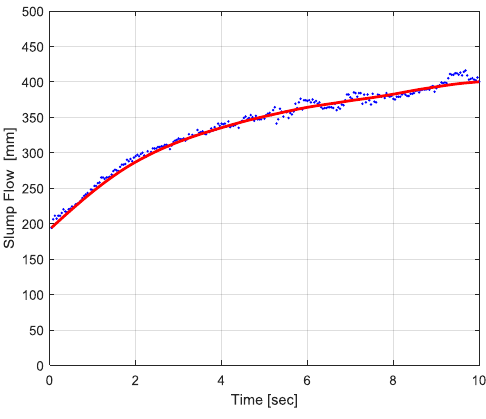
Figure 16. Slump flow diameter over time.